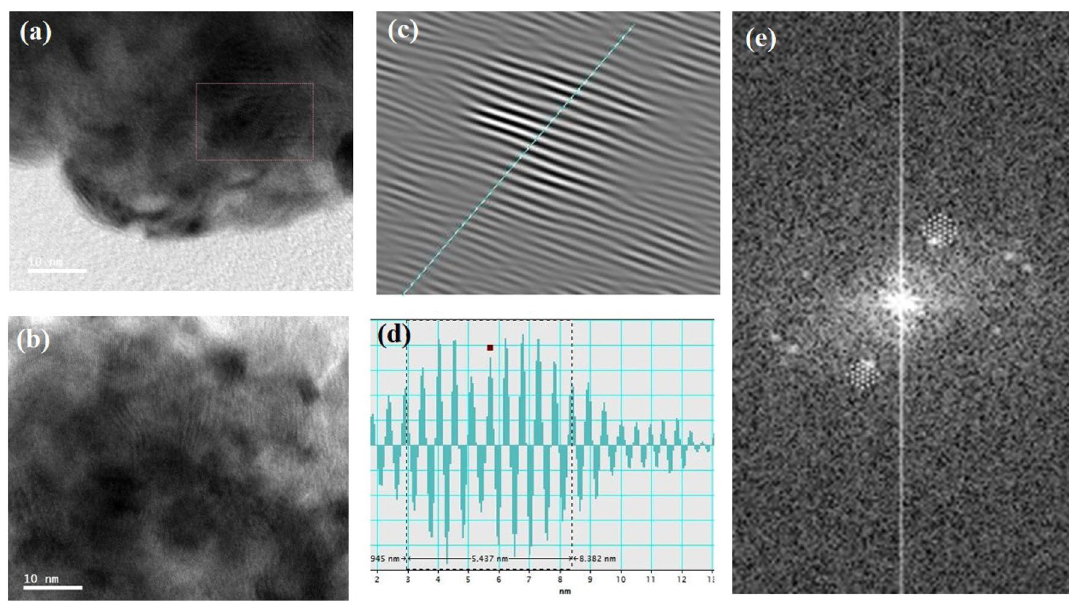
Fig. 5 a , b HR-TEM micrograph of prepared CdS, c Fourier filtered image of the planes, d FFT spectrum of ZnS, e FFT image of CdS